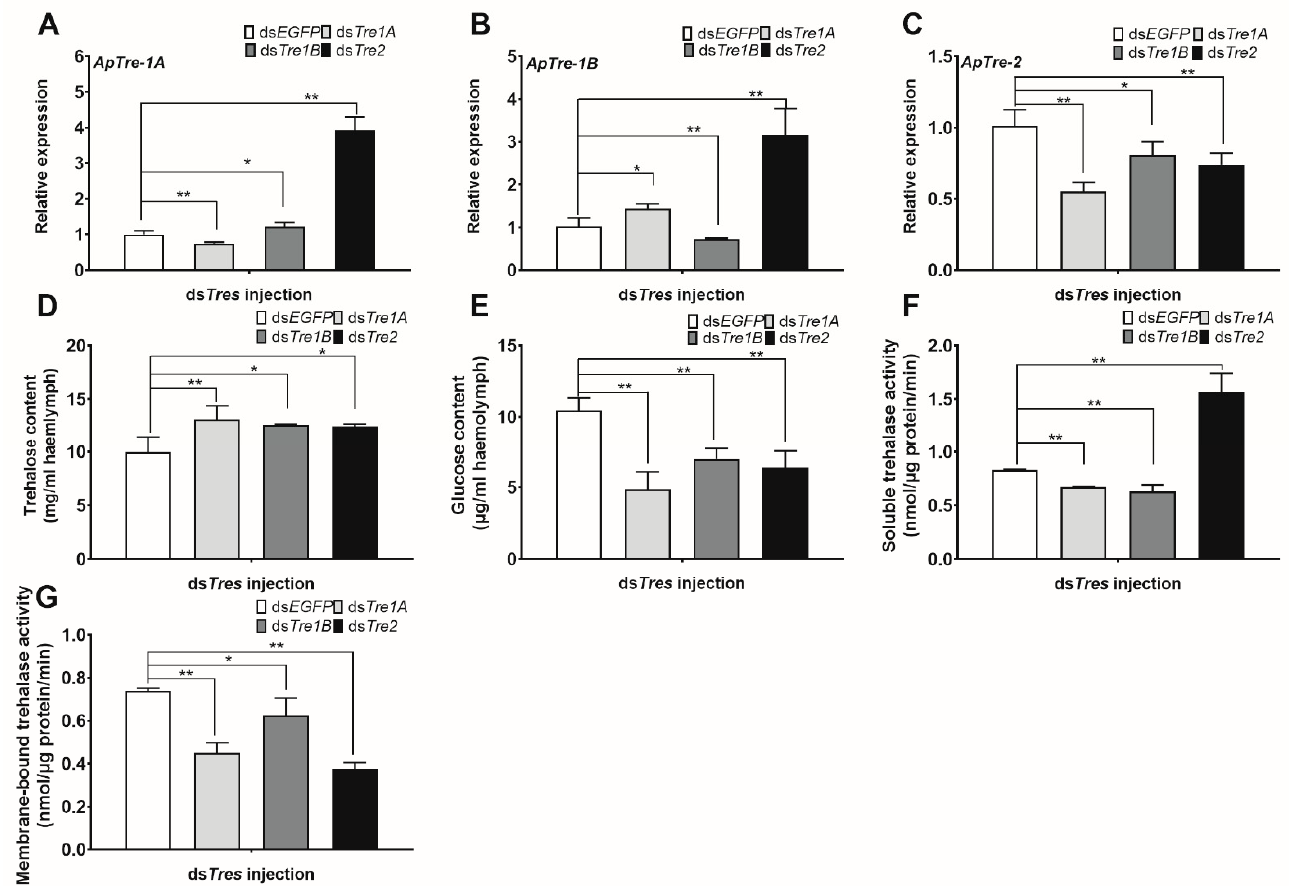
Figure 6. Effects of RNAi targeting the three ApTres on trehalose catabolism in A. pernyi pupae. ( A – C ) Relative expression levels of ApTre-1A , ApTre-1B , and ApTre-2 , respectively, at 48 h after RNAi targeting the three ApTres . ( D , E ) Changes in trehalose and glucose content, respectively, in the haemolymph at 48 h after RNAi targeting the three ApTres . ( F , G ) Changes in soluble and membrane-bound trehalase activity, respectively, at 48 h after RNAi targeting the three ApTres . mRNA levels were normalised to those of the reference genes actin and RP49 , and the group injected with ds EGFP served as controls. Data are means of three independent experiments, and error bars are SEs. Single asterisks ( p < 0.05) and double asterisks ( p < 0.01) represent significant differences between the ds EGFP and ds ApTres groups in the same time period.